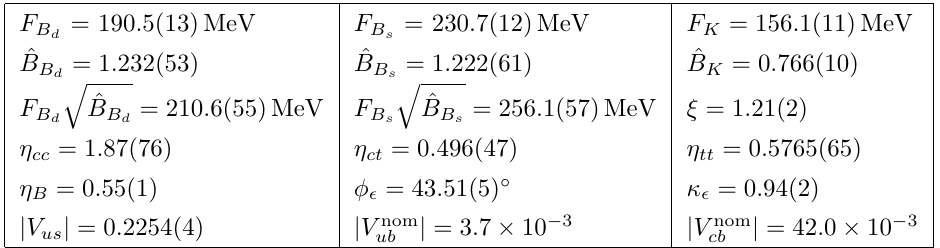
Table 2 . Numerical values used for the numerical